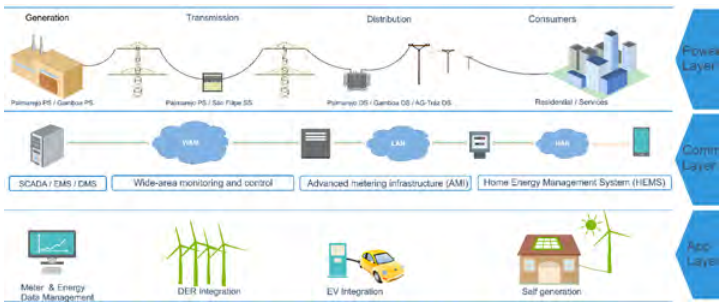
Figure 6. Layout of Smart Grid system proposed for Praia